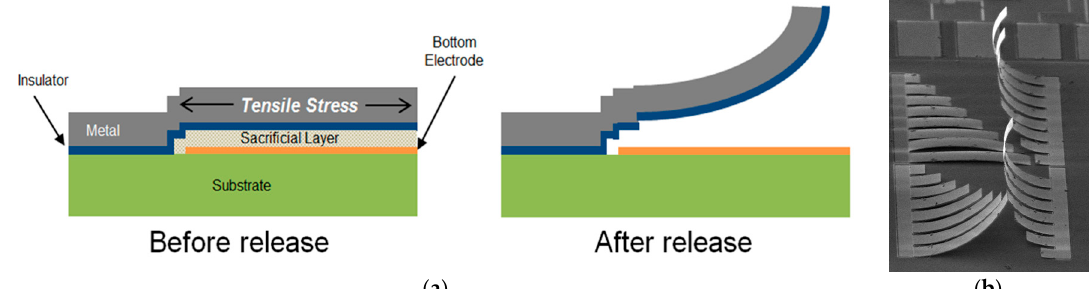
Figure 2. Illustration of the overall design concept of the actuation assembly for large out-of-plane deflections. The left image shows the as deposited layers prior to release while the right image illustrates the post released structure showing the out-of-plane upward